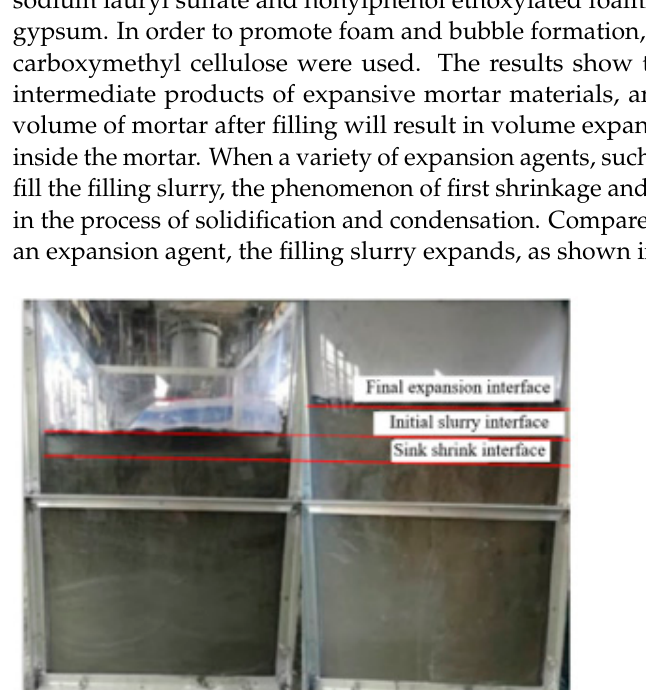
Figure 12. Effect of backfilling body with expansion agent.